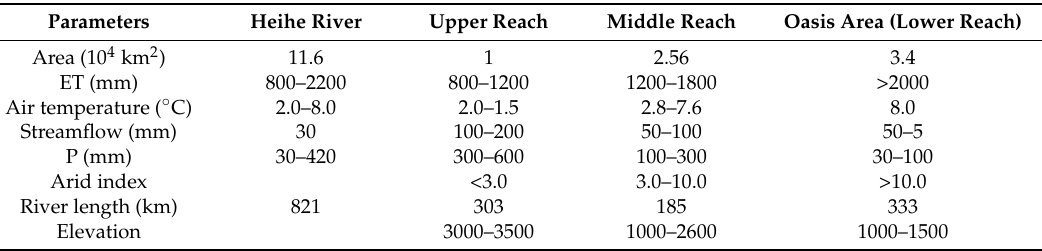
Figure 2. The geological cross section of the Ejina Oasis area in the lower subbasin. Table 1. Parameters of the three reaches.